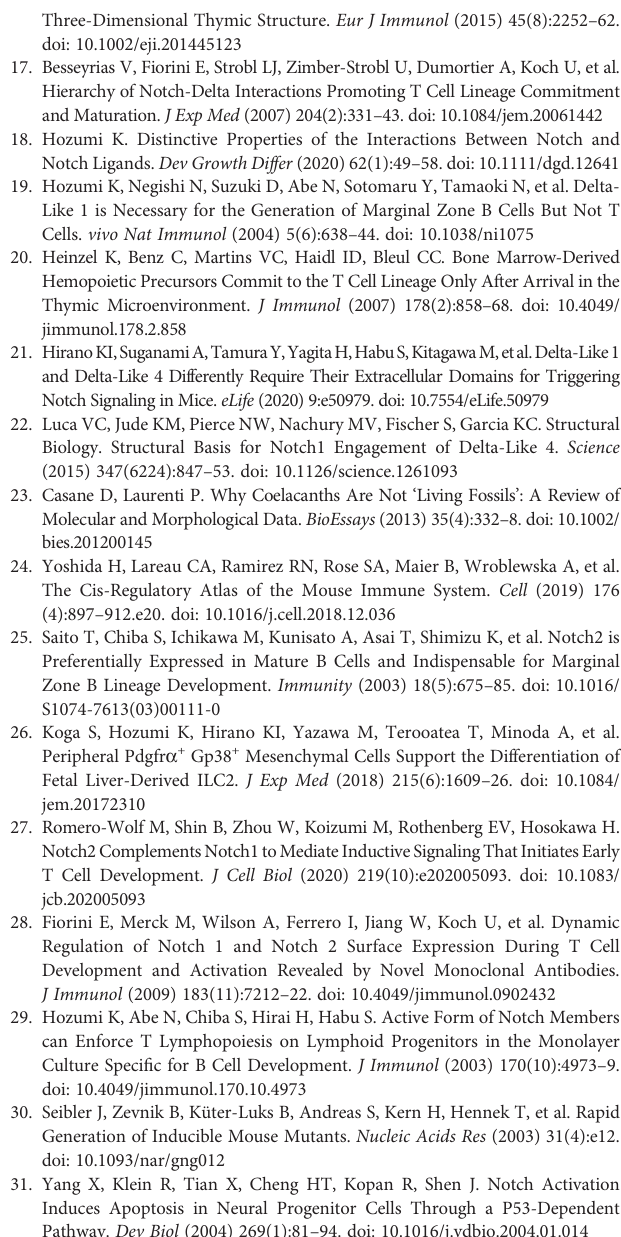
Supplementary Figure 5 | Phylogenetic analysis of Notch1 and Notch2 was performed as shown in Supplementary Figure 1 . The tree with the highest log likelihood (-55656.23) is shown. This analysis involved 18 amino acid sequences with a total of 2848 positions in the fi nal